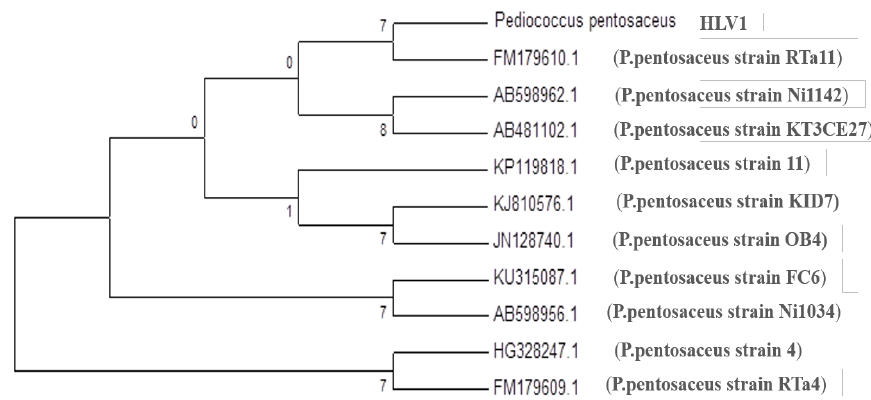
Figure 2. Phylogenetic tree derived from maximum likelihood method by MEGA7.